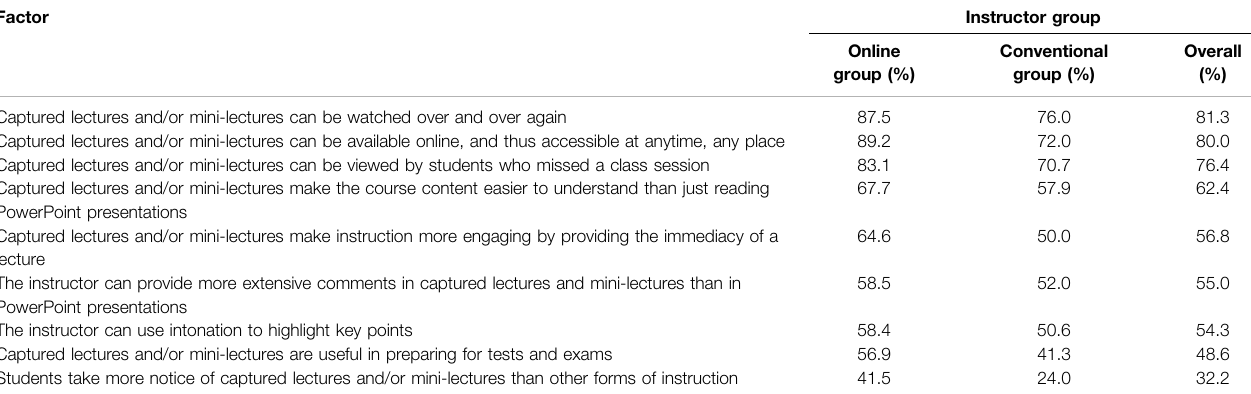
TABLE5| Percentageofinstructorsintheonlinegroupandconventionalgroupratingeachfactoras “ Important ” or “ VeryImportant ” forusingvideosforlecturecaptureand/ or for recording